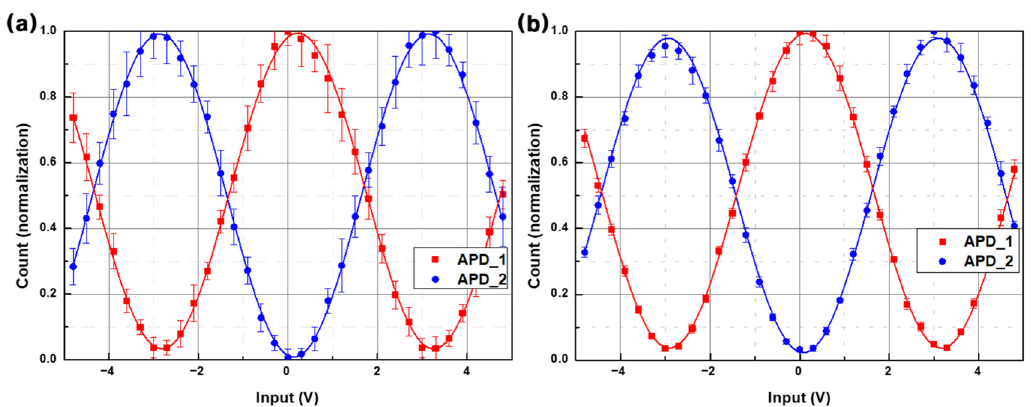
Figure 5. Interference visibility results in ( a ) signal and ( b ) decoy pulse. The measured counts of APD_1 (red) and APD_2 (blue) versus input voltage of PM are shown. It can be seen that the measured counts are well modeled with the sine function. The visibility of signal and decoy pulse are 0.9437 and 0.9540, respectively.